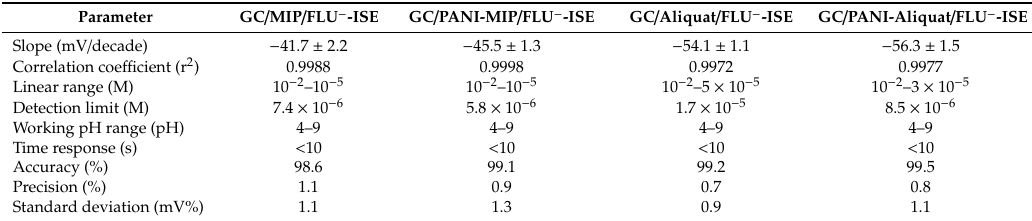
Figure 4. Chronopotentiograms for ( a ) MIP and ( b ) Aliquat based sensors recorded in 10-3M.